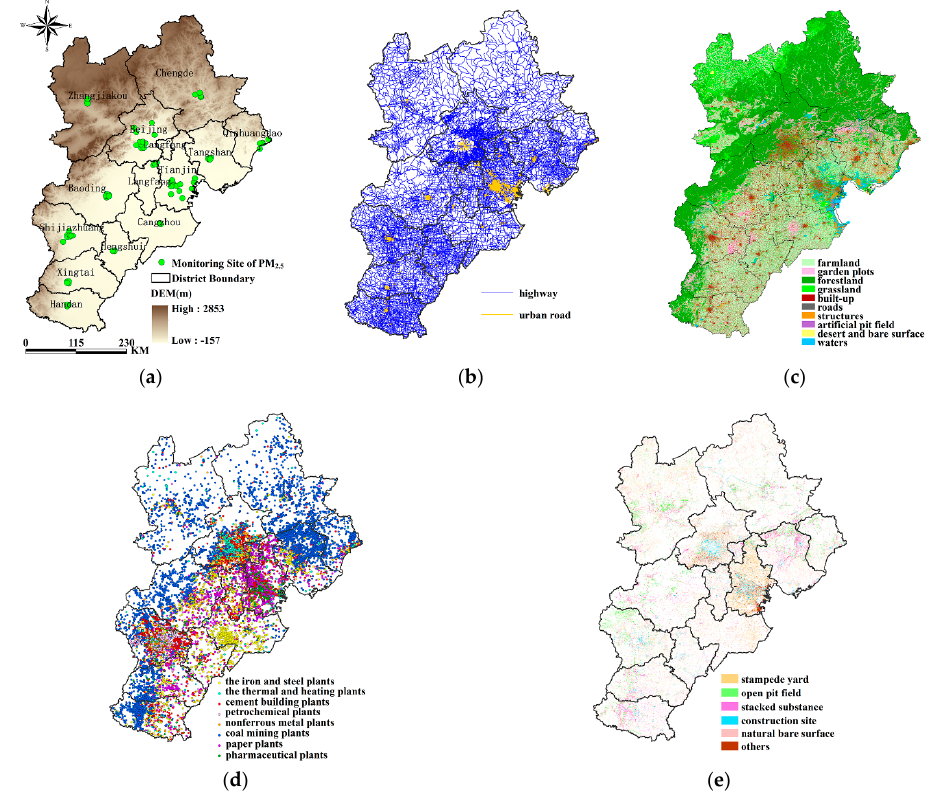
Figure 1. Study area and partial basic geographical feature data: ( a ) PM 2.5 monitoring sites and elevation; ( b ) road traffic; ( c ) land use/cover; ( d ) industrial plants; and ( e ) surface dust.